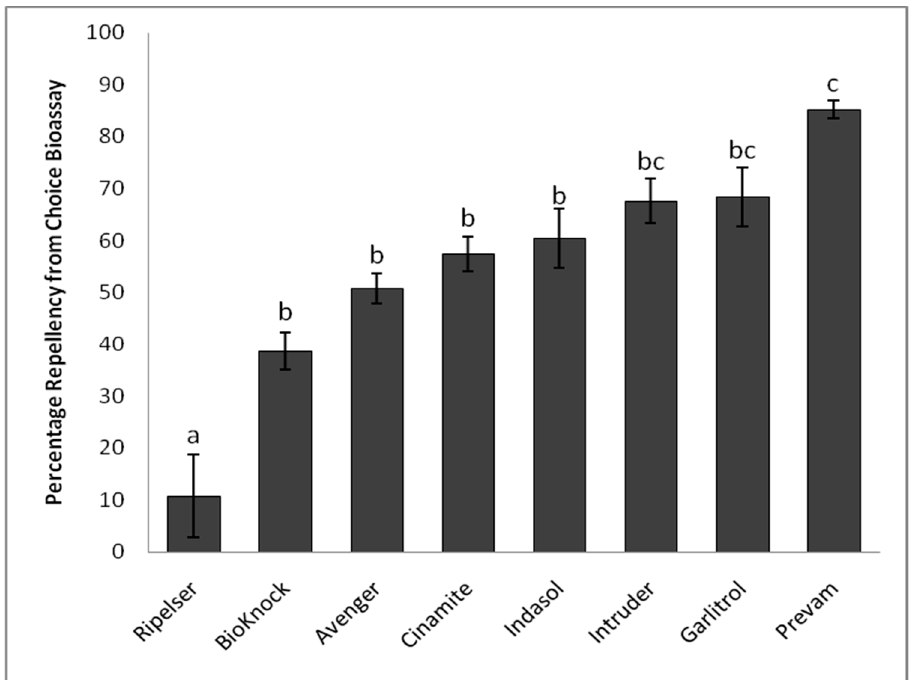
Figure 1. Repellence test of selected products on the 2nd instar larvae of C. chalcites under laboratory conditions (choice assay). Different letters above bars indicate a significant difference among the groups according to ANOVA followed by Tukey’s HSD test ( p < 0.05).